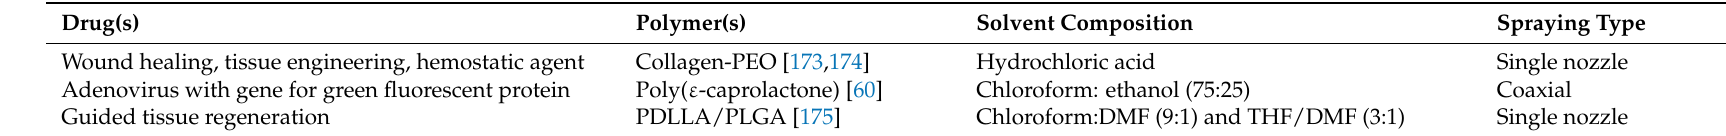
Table 3. Studies involving the use of electrospun fibers in tissue engineering (partial